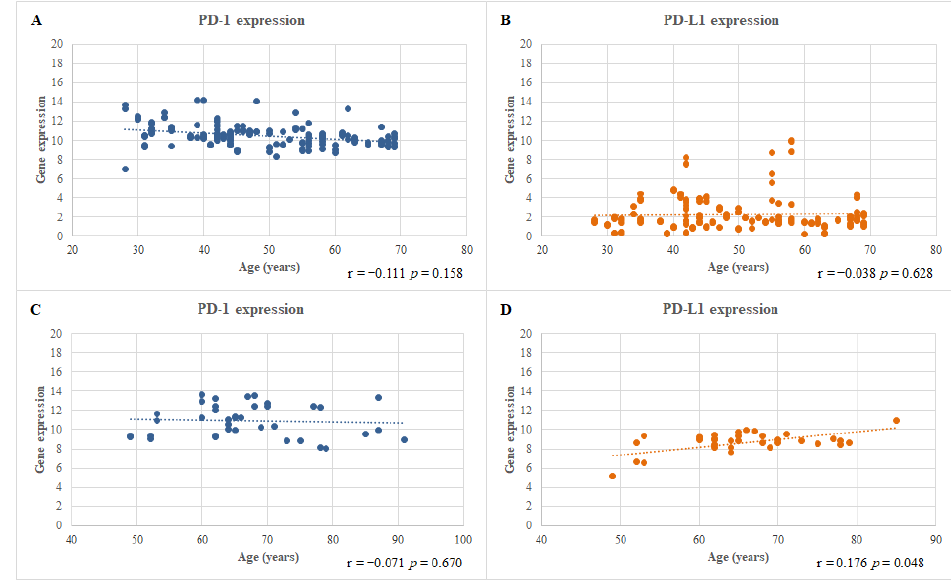
Figure 2. Correlation between the mRNA expression level of PD-1 ( A , C ) and PD-L1 ( B , D ) genes and the ages of CRSwNP patients ( A , B ) and of HNC patients ( C , D ).